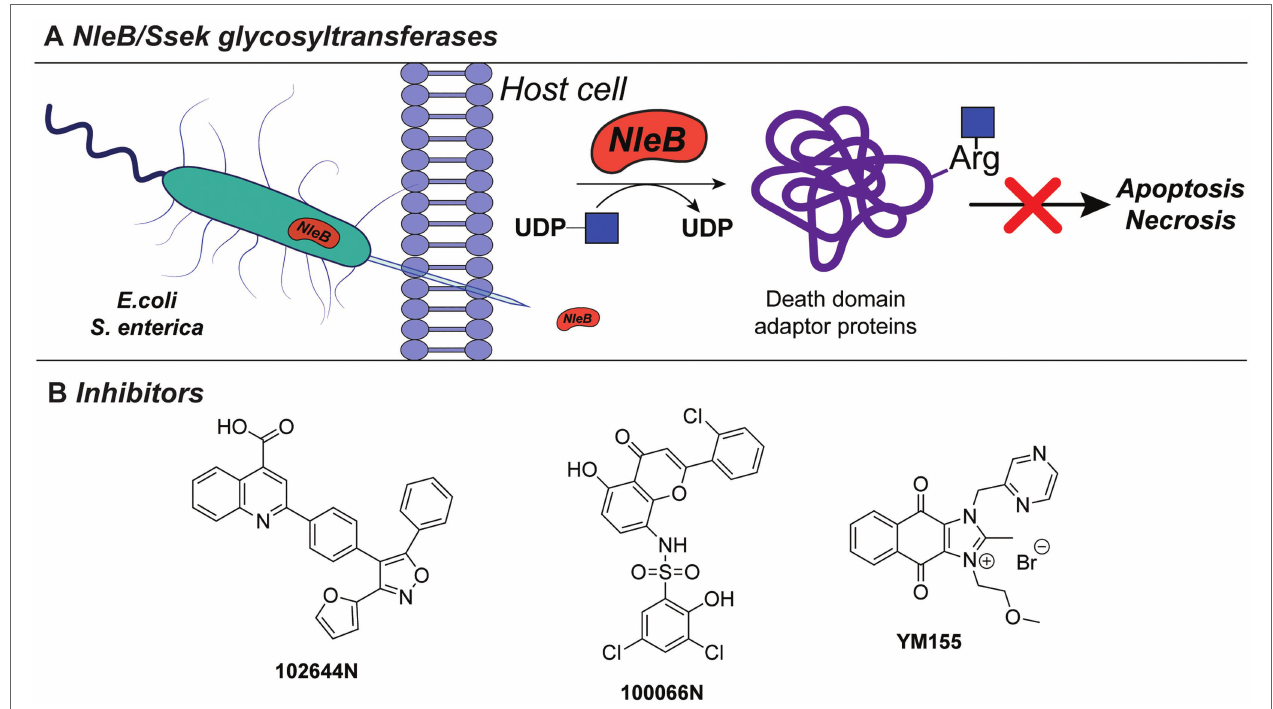
FIGURE 7 | (A) NleB/Ssek exotoxin system. (B) Developed inhibitors against NleB/Ssek discussed in this